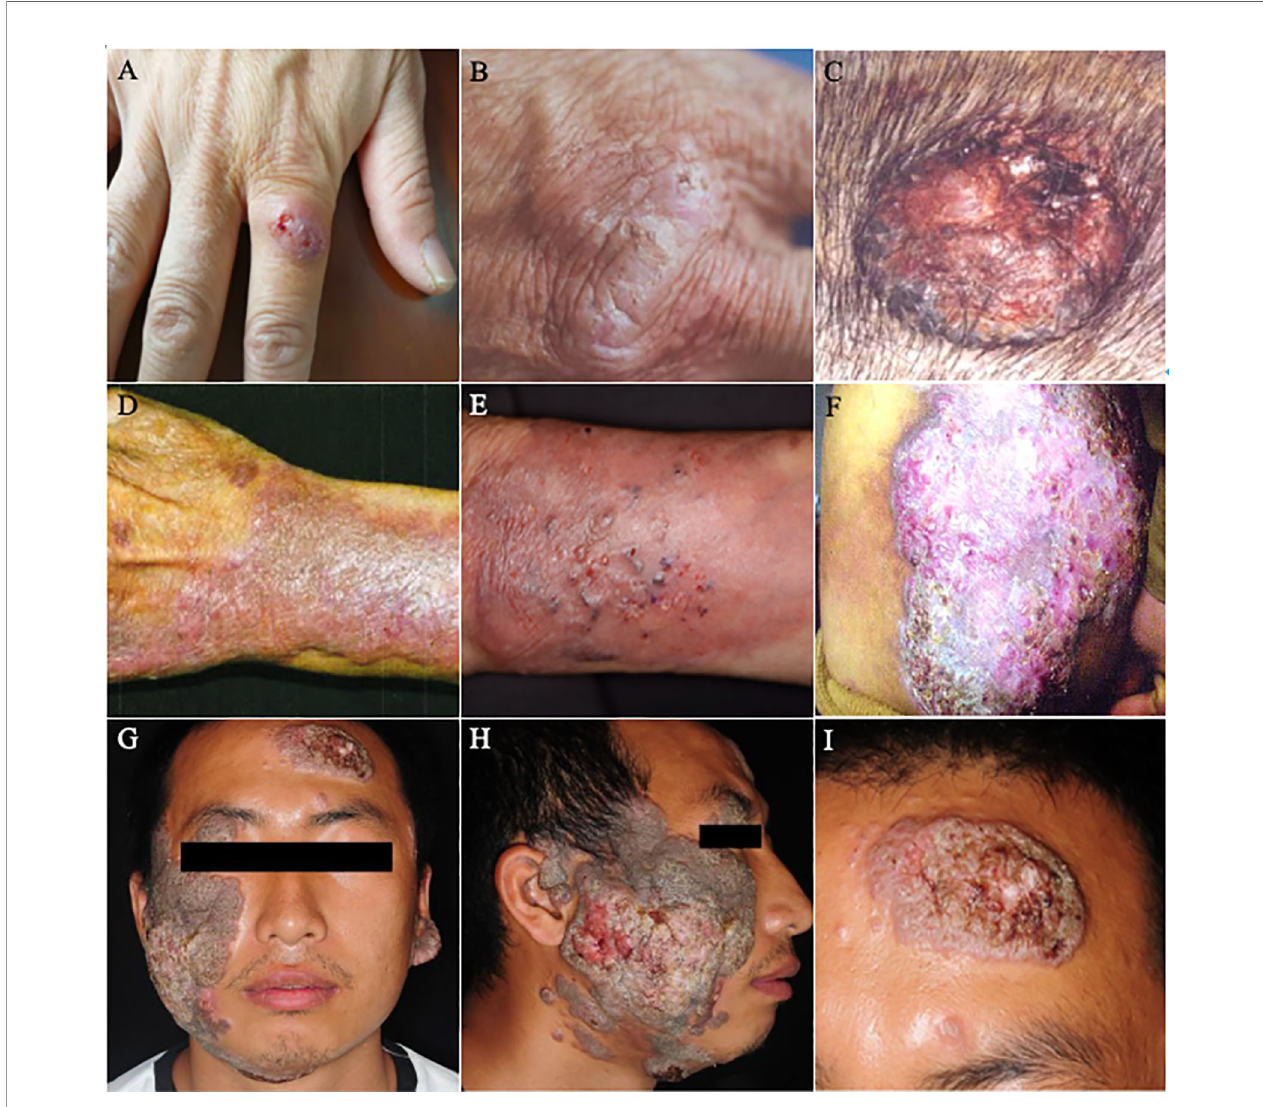
FIGURE 4 | Lesions of PHM with different severity grades. (A – C) Mild forms ( (A) : Reproduced from reference Linqiang et al. (2020) [original Figure 1A ]); (B) : Reproduced from reference Huang et al. (2008) [original Figure 1 ]; (C) : Reproduced from reference Lin et al. (2010) [original Figure 1A ]); (D – F) Moderate forms ( (D) : Reproduced from reference Liu et al. (2013) [original Figure 1 ]; (E) : Reproduced from reference Yu et al. (2021) [original Figure 1G ]; (F) : Reproduced from reference Lv et al. (2005) [original Figure 1 ]); (G – I) Severe forms (Reproduced from reference Huang et al. (2019) [original Figure A – C